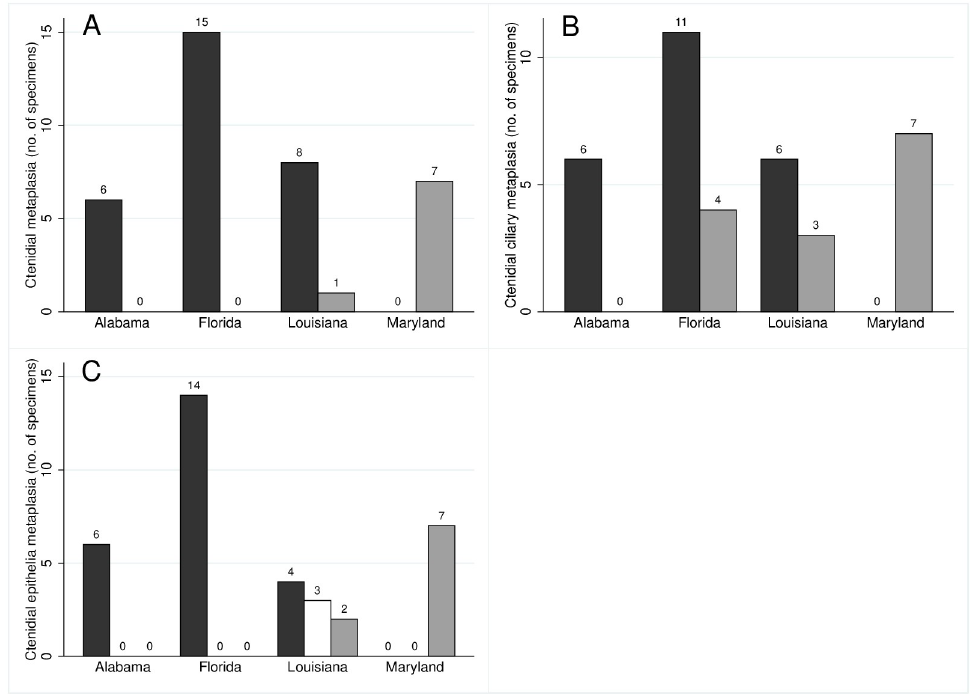
Fig 2. Numbers of specimens displaying ctenidial metaplasia. A—Occurrence of any type of ctenidial metaplasia (black) versus non-metaplasial individuals (grey). B—Absence of ctenidial cilia (black) versus presence (grey). C—Alteration of ctendial epithelia (black), healthy epithelia (grey), and mixed altered and healthy in the same individual (white). Locations are Barataria Bay (Louisiana), Dauphin Island (Alabama), Apalachicola (Florida) and Chesapeake Bay (Maryland). Numbers above bars indicate the number of specimens. The results are summarized for all sampled